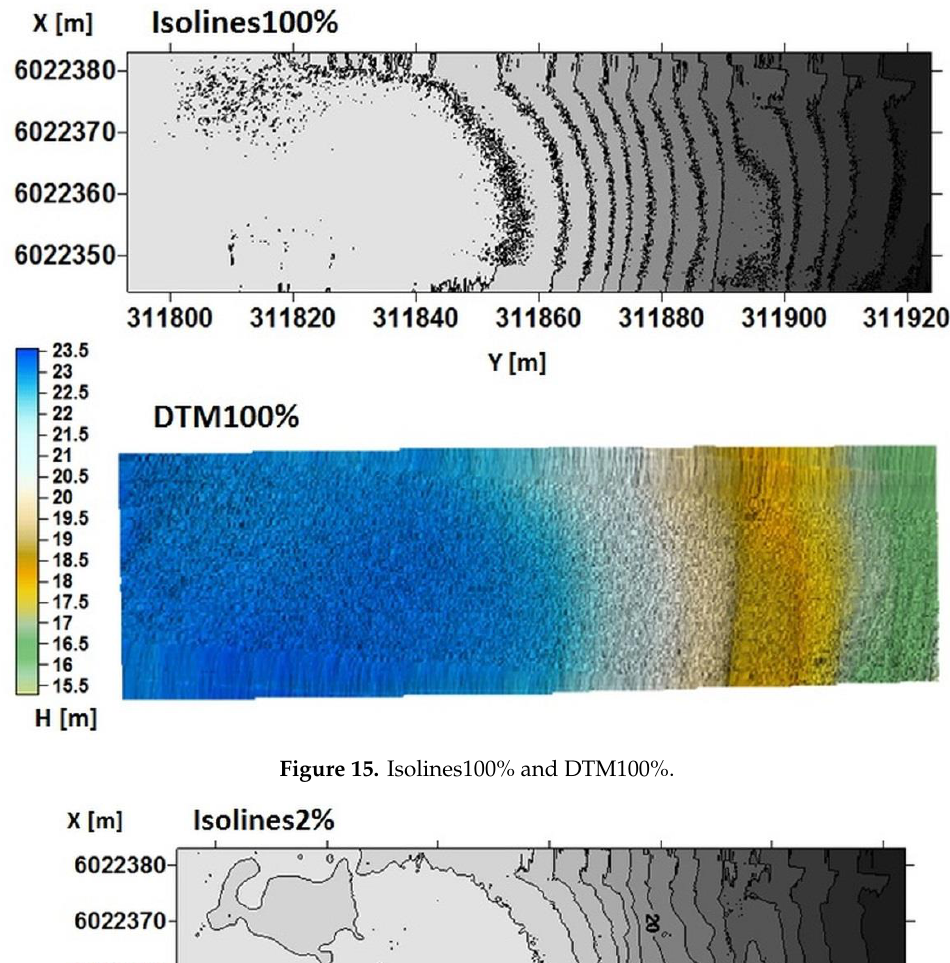
Remote Sens. 2019 , 11 , x FOR PEER REVIEW Figure 15. Isolines100% and DTM100%. Figure 15. Isolines100% and DTM100%.